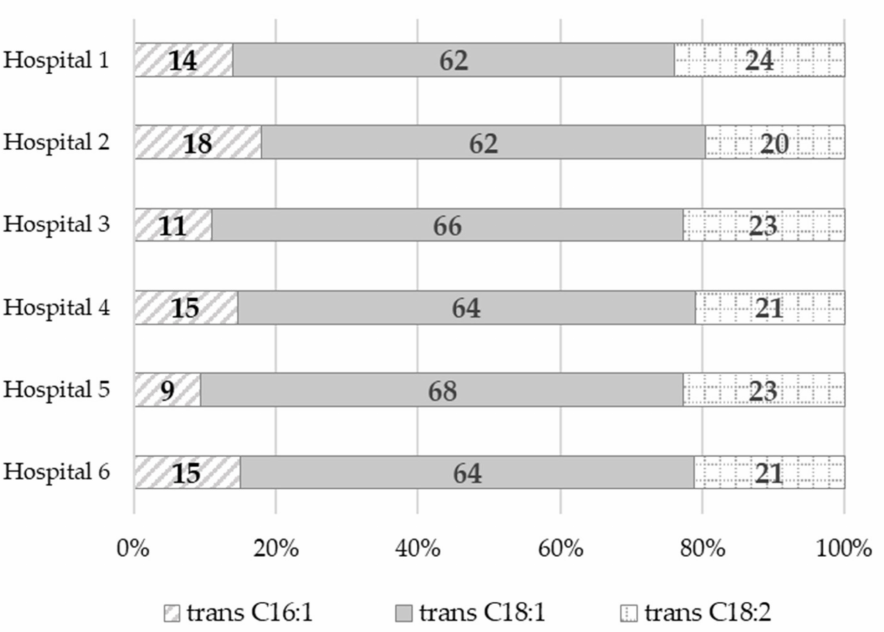
Figure 1. The percentage share (%) of individual trans isomers in the group of all the trans fatty acids identified in the whole-day hospitals’